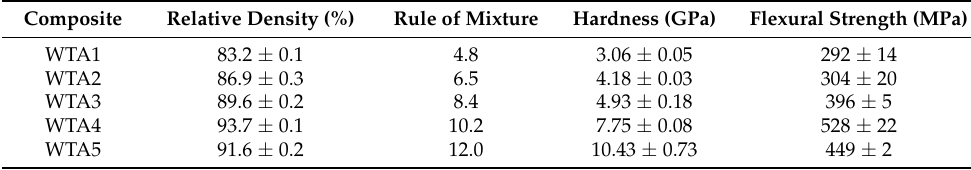
Table 2. Mechanical properties of W-TaC composites.